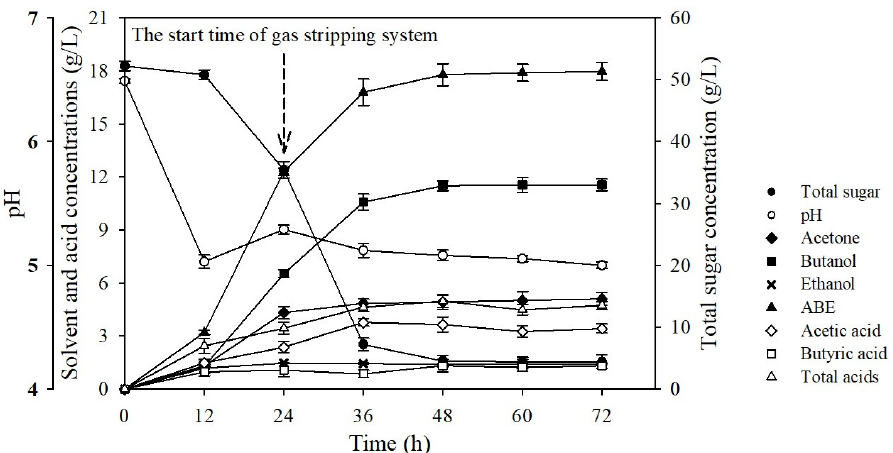
Figure 7. Profiles of ABE fermentation from sugarcane molasses by C. beijerinckii TISTR 1461 using an internal loop gas-lift bioreactor integrated with a gas stripping system.